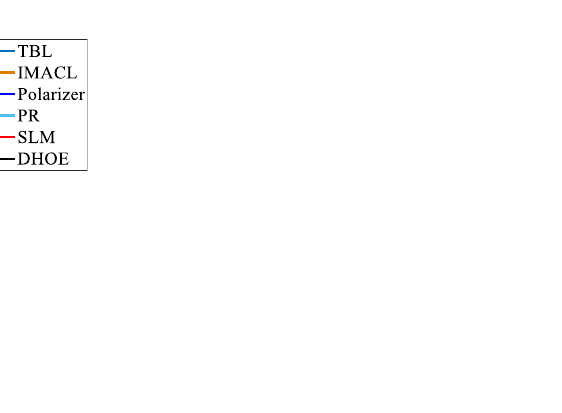
and ( b ) DHOE with °